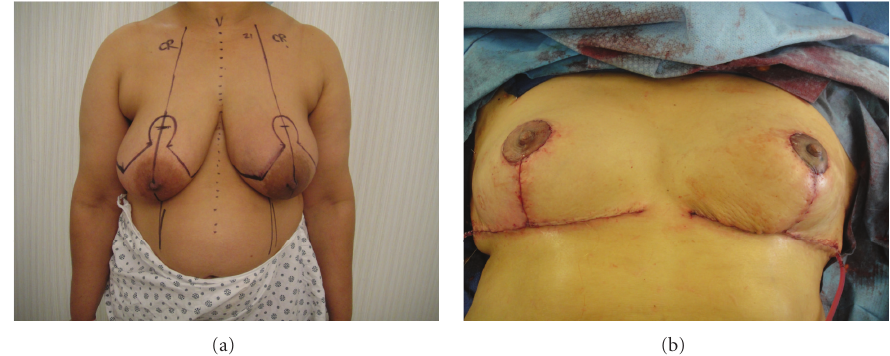
Figure 1: (a) Preoperative markings before Wise pattern superomedial pedicle oncoplastic breast reduction. The patient’s breast cancer is located in the inferolateral breast. (b) Immediate on-table result after oncoplastic breast reduction showing location of